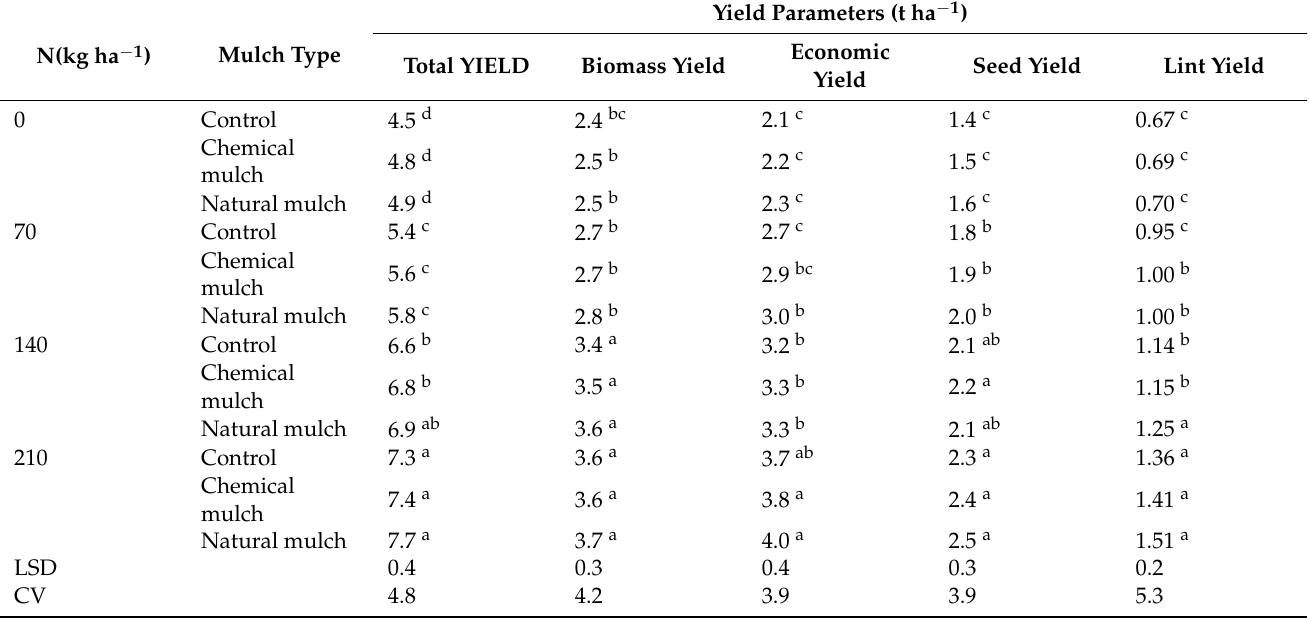
Table 3. Effects of nitrogen fertilization with mulch application on total biomass, economic, seed, and lint yields of cotton during